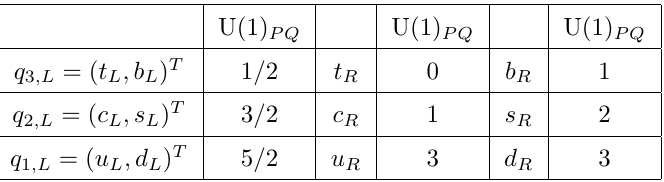
Table 1 . PQ charges of elementary quarks. The PQ charge of u R appears out of the pattern. As discussed in the text, the up quark Yukawa coupling comes from the U(1) PQ violating coupling, which also generates the required ~ H y H 1 2